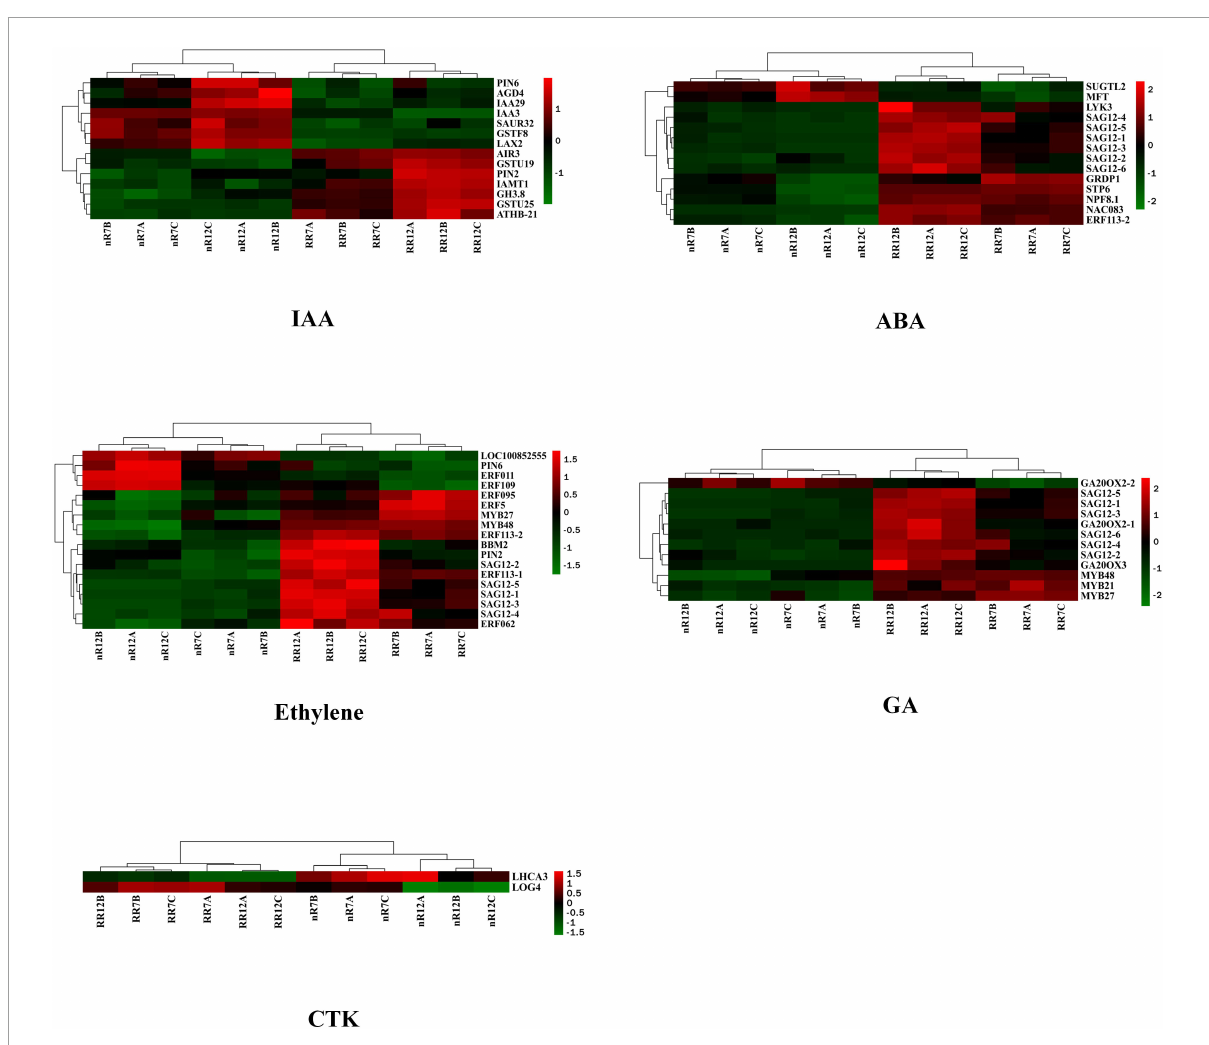
FIGURE4 Heat map analysis of differentially expressed genes in response to phytohormones IAA, ABA, ETH, GA, and CTK. nR7, RR7, nR12, and RR12 represent the 70 DAP and 125 DAP sampling points under nR and RR